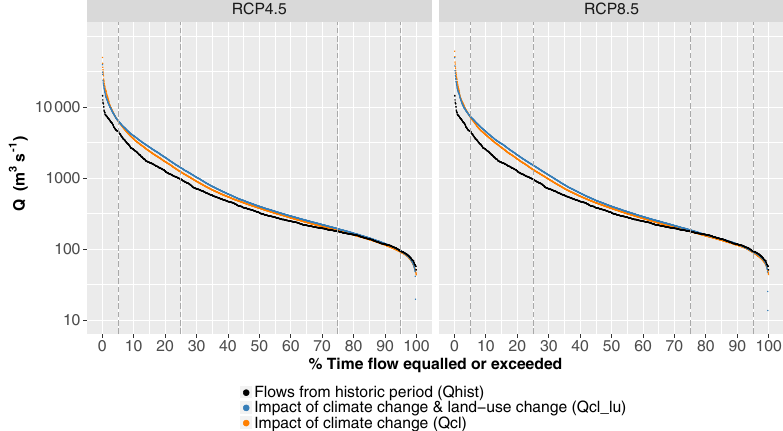
Figure 6. Flow duration curves of the streamflows simulated by JULES for the Upper Ganges basin, at Kanpur barrage. Orange: multi-model mean values when only climate change is taken into account (Q cl ) ; simulation period 2030–2035. Blue: multi-model mean values when both climate change and land-use change are taken into account (Q cl_lu ) ; simulation period 2030–2035. Black: historical period (Q hist ) ; simulation period 2000–2005.